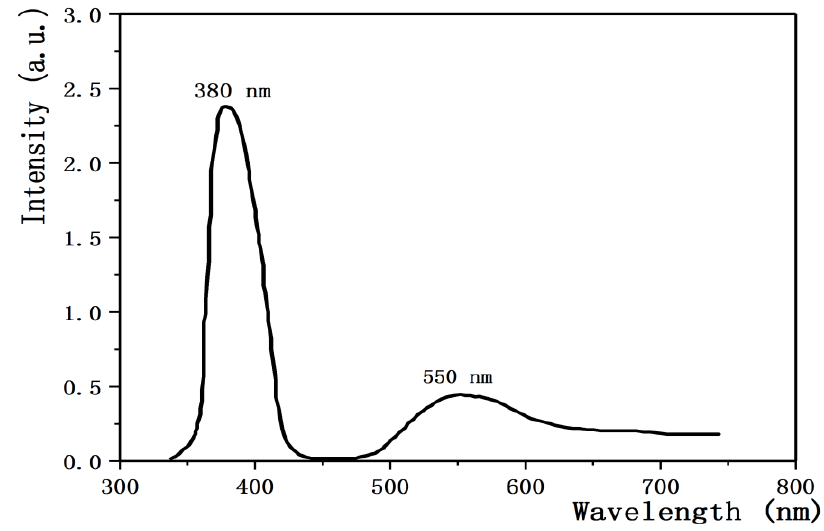
Figure 2. The photoluminescence spectrum of ZnO thin films at room temperature [36].